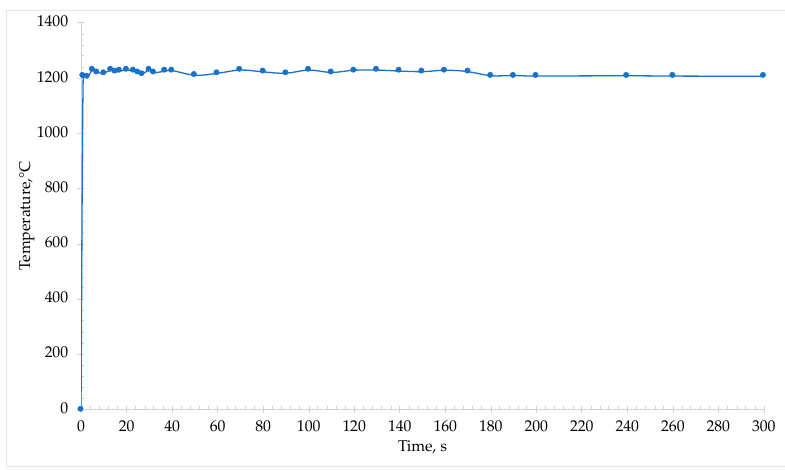
Figure 8. Heating rates of 2nd MW roasting process at 0.6 kW, 1 L/min N 2 flow constant and 300 s. At this temperature it was possible to note the reduction of iron oxide into metallic iron and the formation of metal phase. Macroscopically, the 2nd cinder appeared similar to the one from the first microwave treatment, but the iron nuggets were smaller in